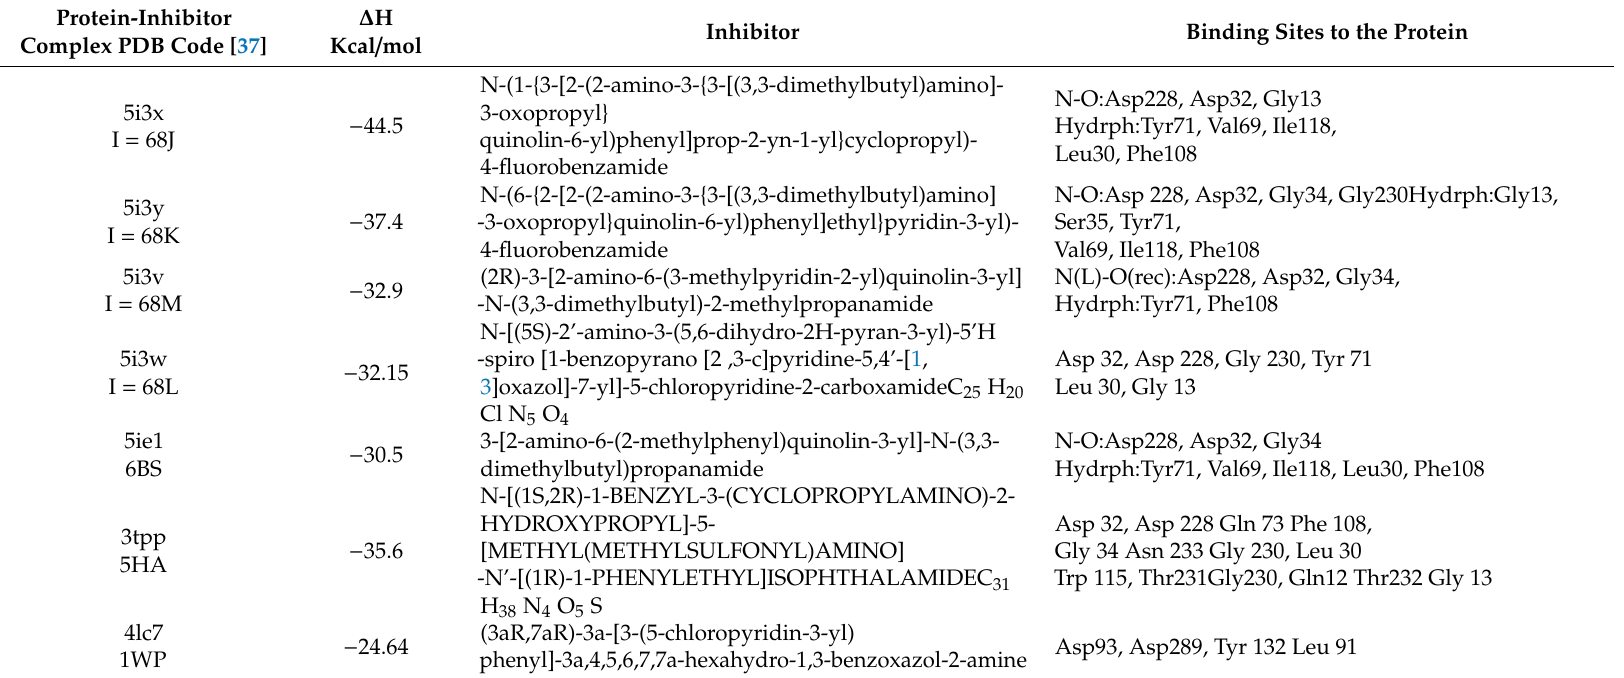
Table 5. Details of binding of inhibitors to BACE1 extracted from average